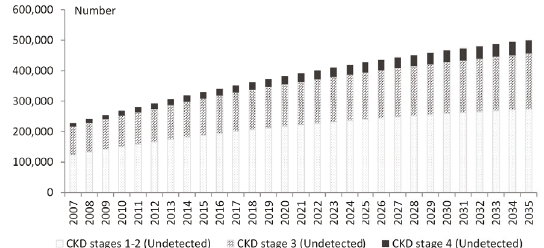
Figure 3: Number of undiagnosed cases of CKD by stage, with projection till